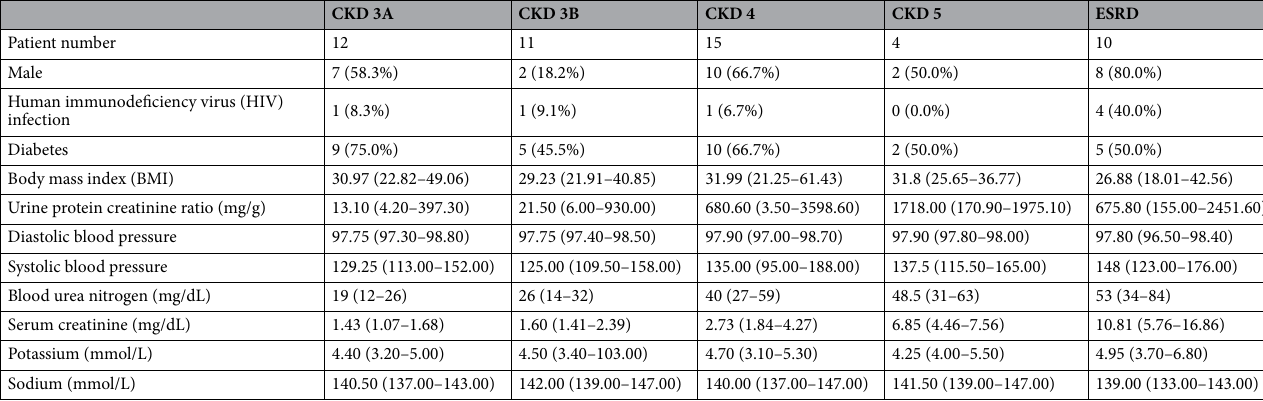
Table 1. Patients’